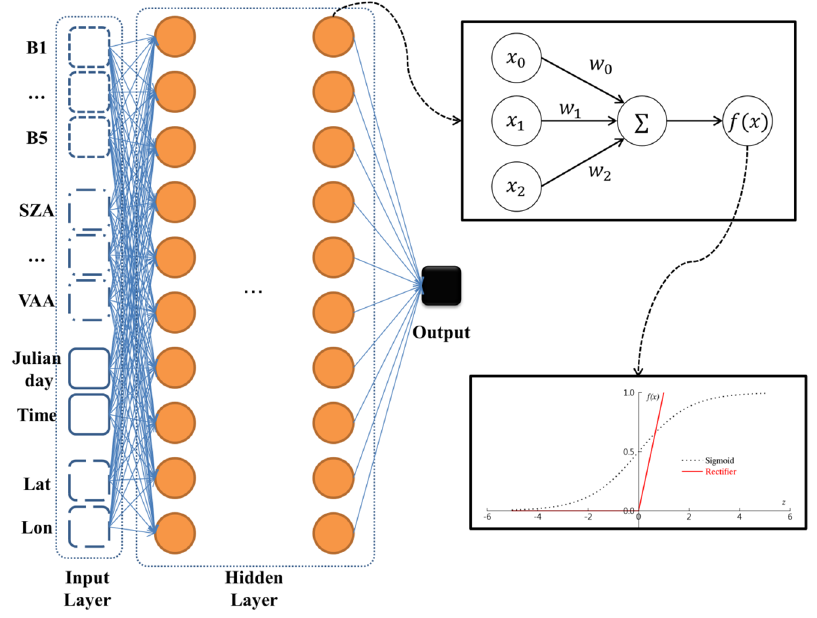
Table 3. Parameters of the training model used to find an optimal structure for retrieving solar radiation.